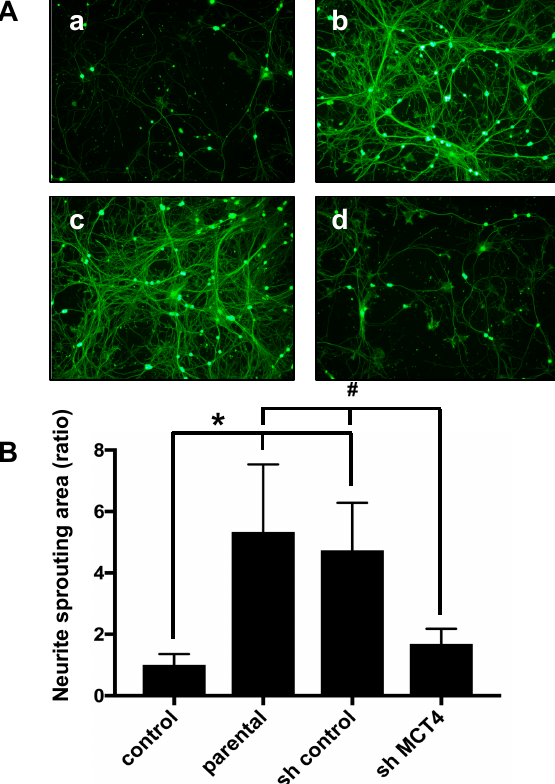
Figure 2. Reduction of MCT4 protein in HNSCC SAS cells. ( A ) The expression of MCT4 in SAS cells. After the stable transfection of SAS cells with control shRNA (sh-control) and MCT4 shRNA (sh-MCT4), the transfected and non-transfected cells (parental) were analyzed by western blotting. The expression of MCT4 in sh-MCT4 analyzed with image blot density was approximately one-half that of the parental cells. ( B ) Immunofluorescence analysis of MCT4 and 4 (cid:48) ,6-diamidino-2-phenylindole (DAPI) for nuclear staining in the cells. Left, MCT4 (green); middle, DAPI (blue); right, merge. Sections were incubated with rabbit anti-MCT4 (1:100), then with Alexa Fluor 488 anti-rabbit IgG (1:1000) and encapsulated with DAPI. Scale Bar = 100 µ m. ( C ) Proliferation assay. We cultured sh-control and sh-MCT4 cells for seven days and then counted the number of each ( n = 3). There was no significant difference between the cells. Error bars: mean ± SD. ( D ) Each group of SAS cells was cultured for 24 h. The conditioned medium was then collected and the concentration of lactic acid was measured ( n = 3). Error bars: mean ± SD; * p < 0.01 vs. sh-MCT4. ( E ) Each group of SAS cells was cultured for 48 h. The conditioned medium was